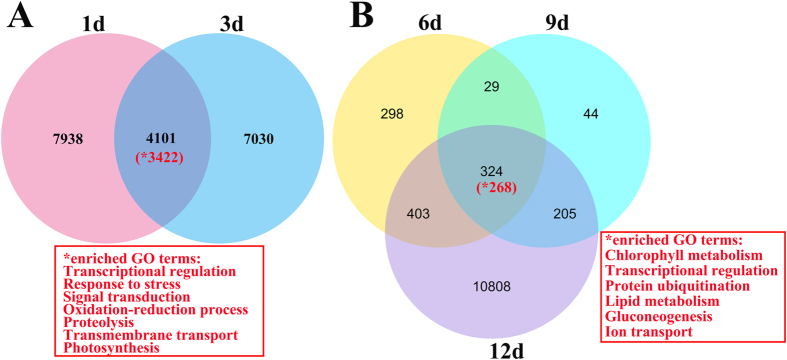
Differentially expressed unigenes and enriched GO terms in non-abscised SDM shoots.(A and B) Number of unigenes differentially expressed in non-abscised SDM shoots at early (A) and late stages (B) in response to ethephon. The enriched GO terms were represented by asterisk (*).